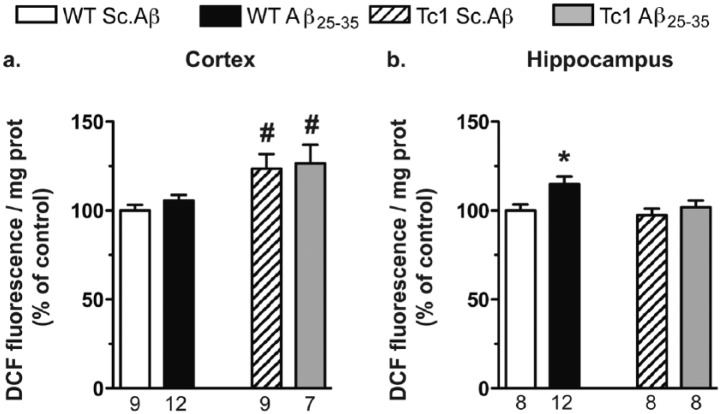
Tc1 mice exhibited increased oxidative stress in the cortex. Oxidative stress was assessed 10 days after intracerebroventricular (i.c.v.) amyloid-β [25-35] (Aβ25-35) injection by measuring reactive oxygen species (ROS) accumulation using dichlorofluorescein (DCF) fluorescence in mouse cortex (a) and hippocampus (b). The number of animals per group is indicated below the columns. Two-way analysis of variance (ANOVA): F(1,33)=12.5, p<0.01 for the genotype, F(1,33)=0.467, p>0.05 for the treatment, F(1,33)=0.049; p>0.05 for the interaction in (a); F(1,32)=3.62, p>0.05 for the genotype, F(1,32)=5.51, p<0.05 for the treatment, F(1,32)=1.61, p>0.05 for the interaction in (b); *p<0.05 vs same genotype scrambled peptide (Sc.Aβ)-treated mice; #p<0.05 vs same treatment wildtype (WT) mice; Bonferroni’s test.